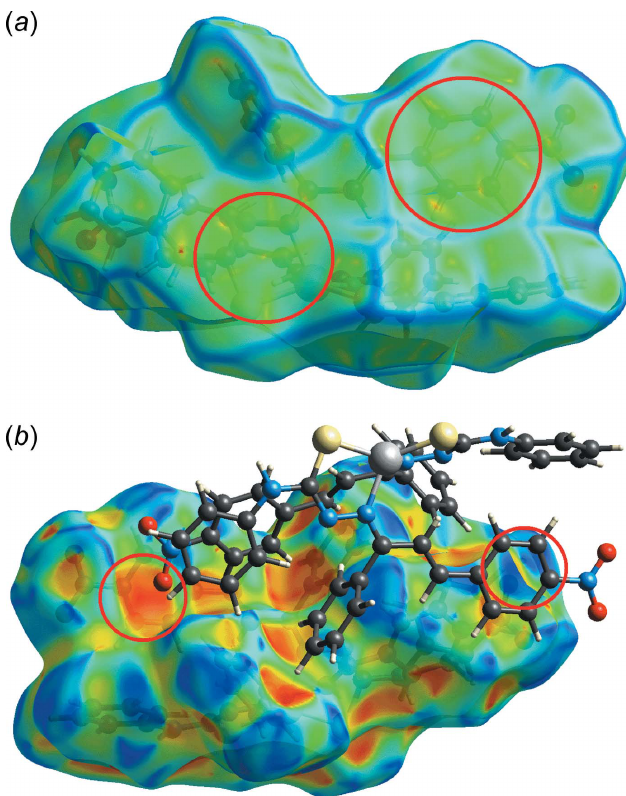
Figure 9 ( a ) A comparison of the full two-dimensional fingerprint plot for (I) and those delineated into ( b ) H (cid:3)(cid:3)(cid:3) H, ( c ) H (cid:3)(cid:3)(cid:3) O/O (cid:3)(cid:3)(cid:3) H, ( d ) H (cid:3)(cid:3)(cid:3) C/C (cid:3)(cid:3)(cid:3) H, ( e ) H (cid:3)(cid:3)(cid:3) S/S (cid:3)(cid:3)(cid:3) H and ( f ) H (cid:3)(cid:3)(cid:3) N/N (cid:3)(cid:3)(cid:3) H